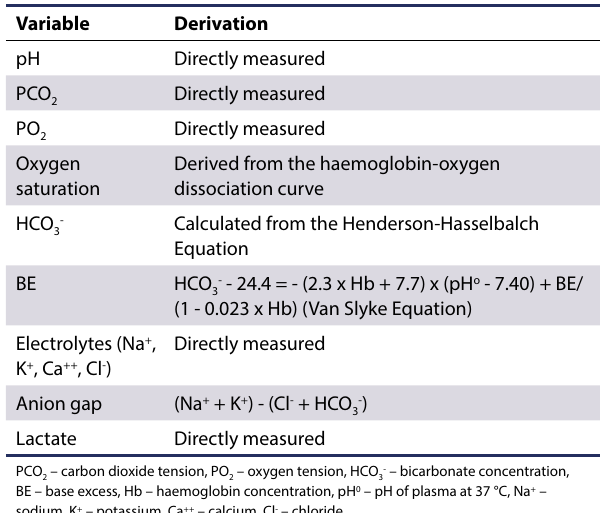
Table I: Source of the variables displayed on the printout from a typical blood gas